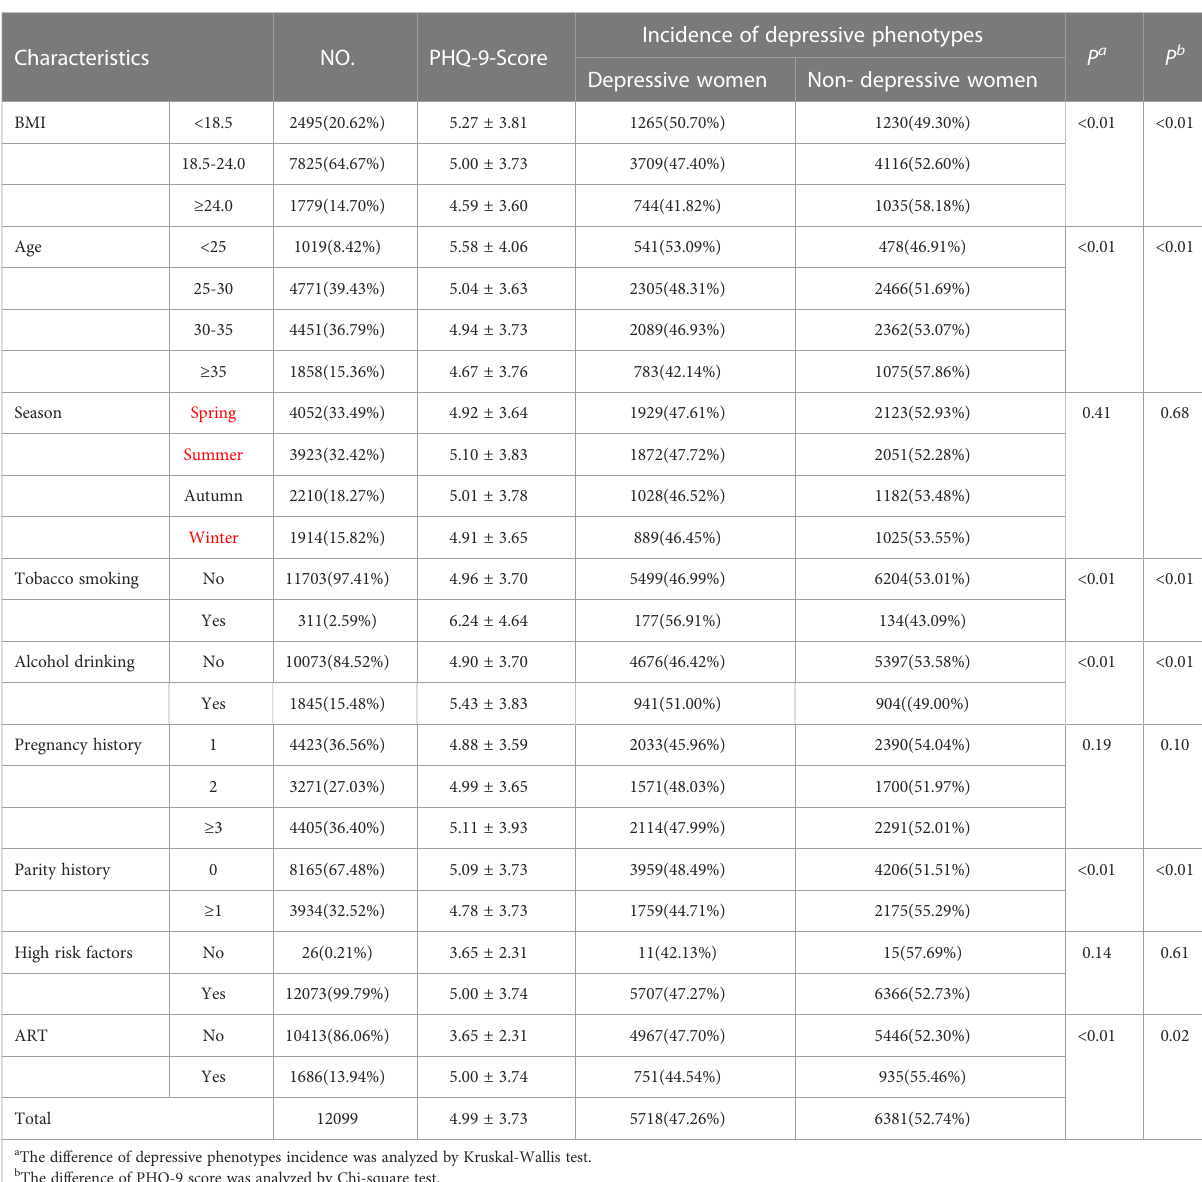
TABLE 1 The distribution of depressive phenotypes estimated by the PHQ-9 and the score of the scale.